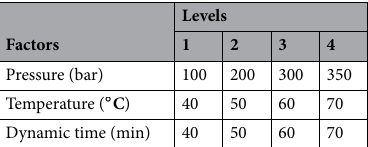
Table 1. The parameters factors and levels of the orthogonal array design L 16